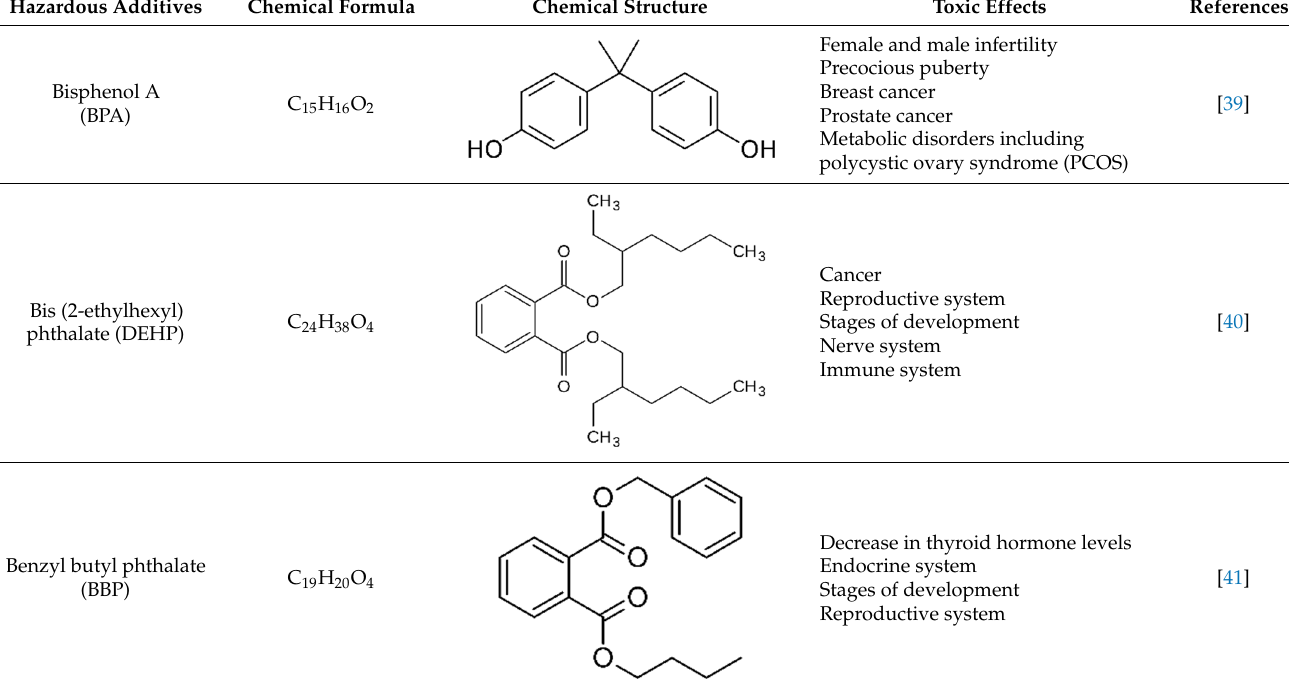
Table 2. Hazardous additives, present in PET products, and their effects.